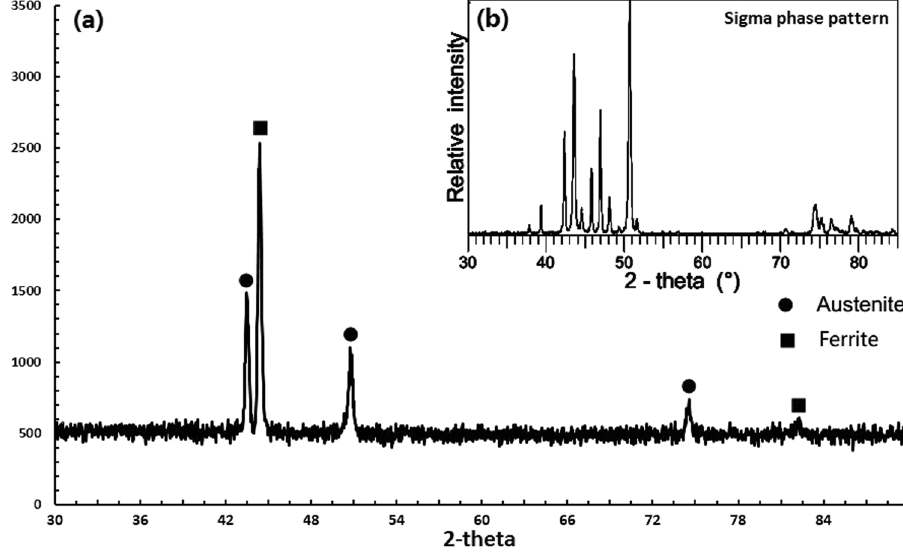
Figure 13. ( a ) XRD pattern at Cr/Fe interface and ( b ) sigma phase XRD patter in the ref. 29.